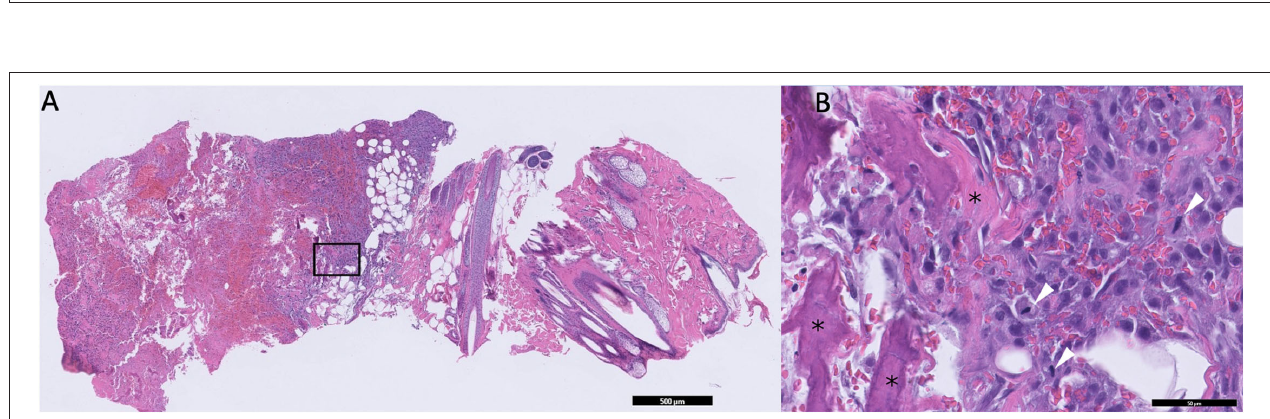
FIGURE 2 | (A) Low magnification microphotograph of the suspected seeded lesion in the subcutaneous tissue. The black box represents the area of increased magnification in B. (B) High-magnification microphotograph of the neoplastic tissue. Areas containing osteoids are marked with asterisks. Tumor cells undergoing mitosis are marked with white